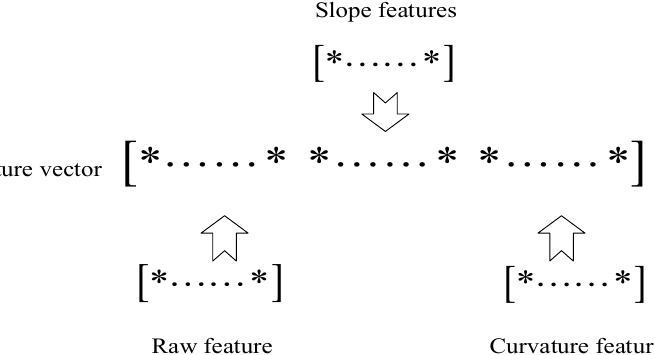
Figure 6. Feature fusion process.